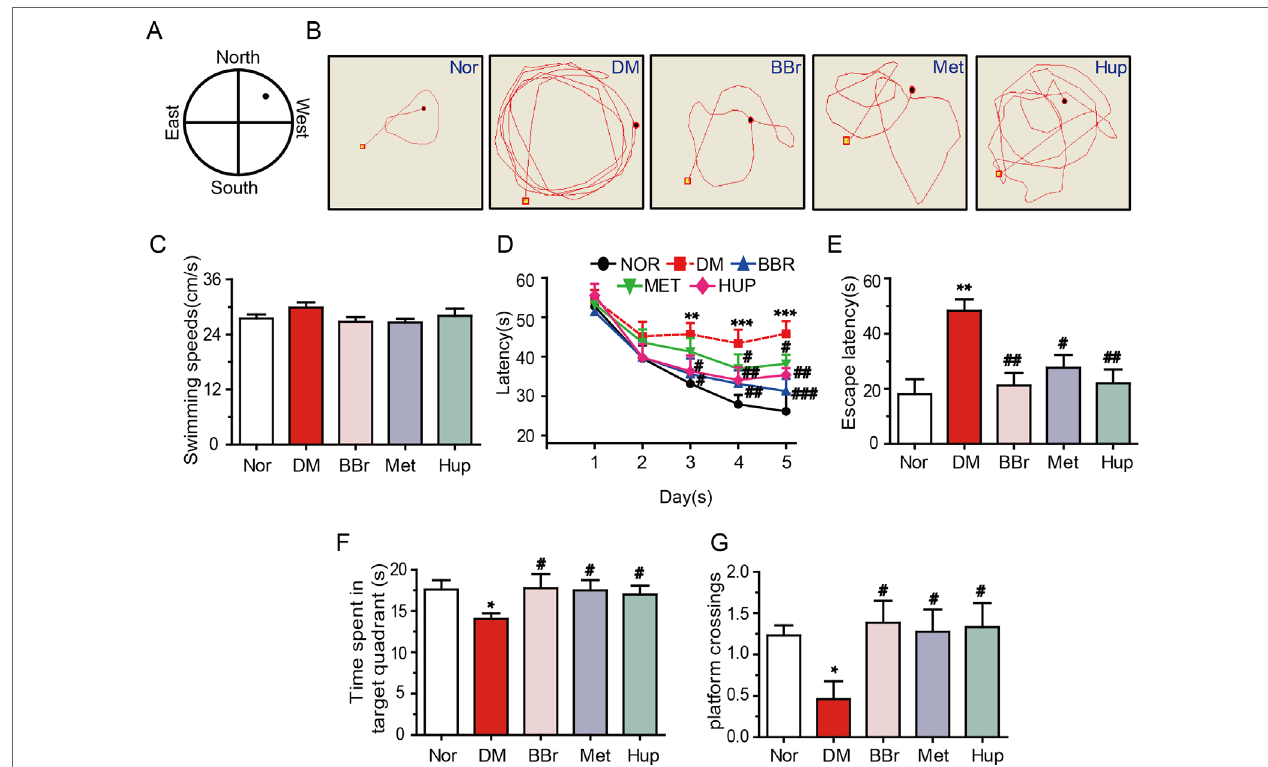
FIGURE 7 | Berberine ameliorates DM-induced cognitive impairment. (A) MWM schematic. (B) The track of rats in MWM. The swimming speed (C) and escape latency analysis in the navigation training trials (D , E) . Time spent in target quadrant (F) and platform crossing (G) in the training trials. n = 8–12. * P < 0.05 vs. Nor; ** P < 0.01 vs. Nor; *** P < 0.001 vs. Nor; # P < 0.05 vs. DM; ## P < 0.01 vs. DM; ### P < 0.01 vs.